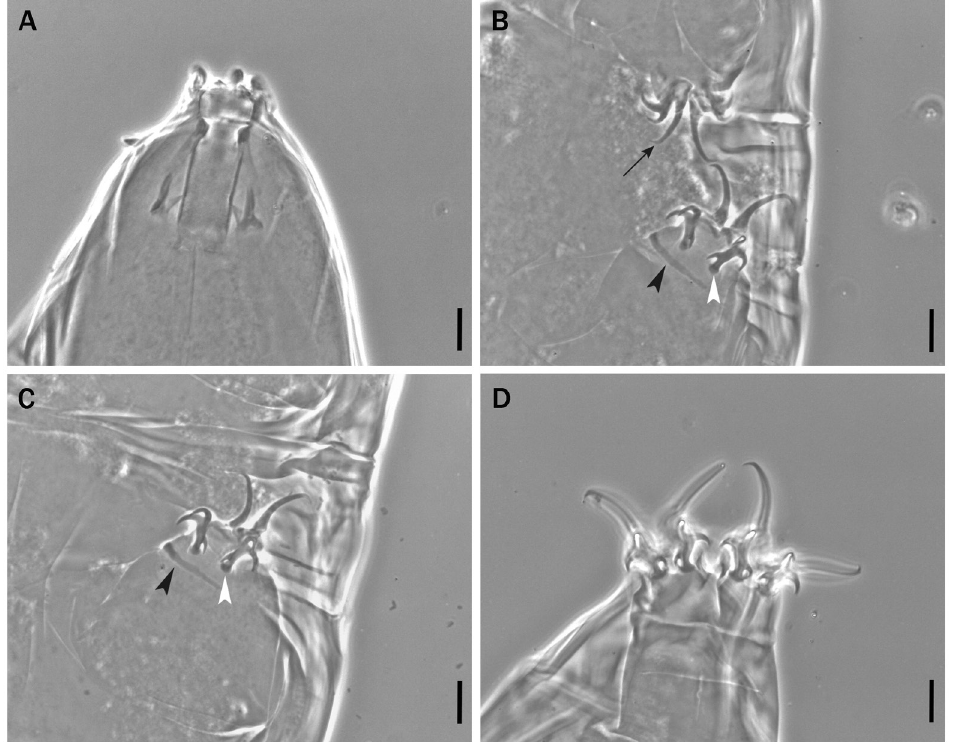
Fig. 19. Milnesium quiranae sp. nov., paratype, ♀ (slide No. UNLPam 566-1). Buccal tube and claws of a young. A . Buccal tube and related structures. B . Legs I and II; the black arrow indicates the accessory points, the black arrowhead indicates the leg cuticular bar, the white arrowhead indicates a lunule. C . Leg III; the black and the white arrowheads indicate the same as in B. D . Legs IV with their claws. Scale bars = 10